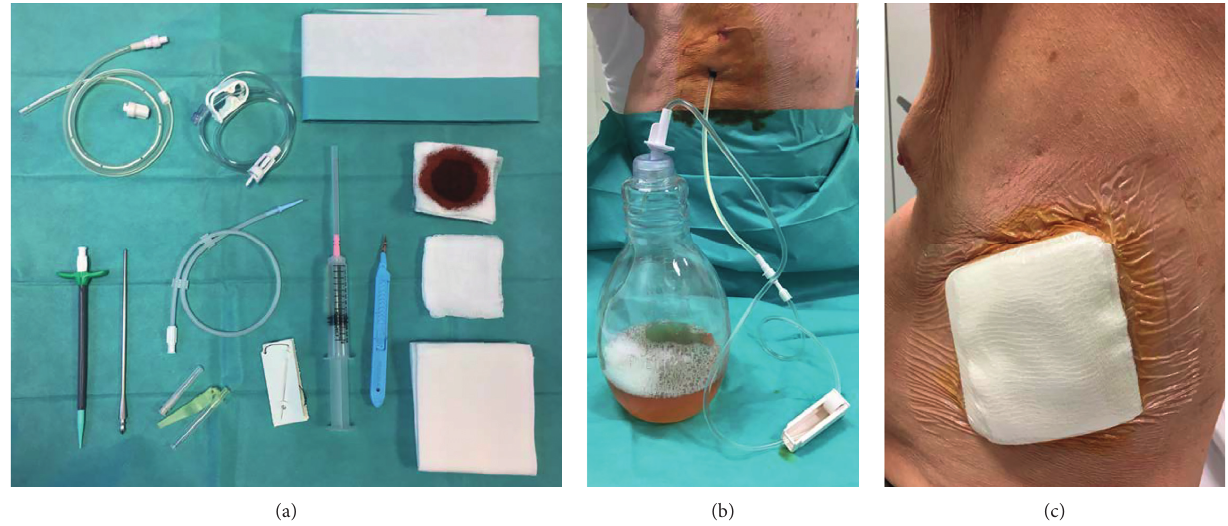
Figure 1: (a) Example of indwelling pleural catheter set. (b) Drainage of indwelling pleural catheter with vacuum bottle. (c) IPC with